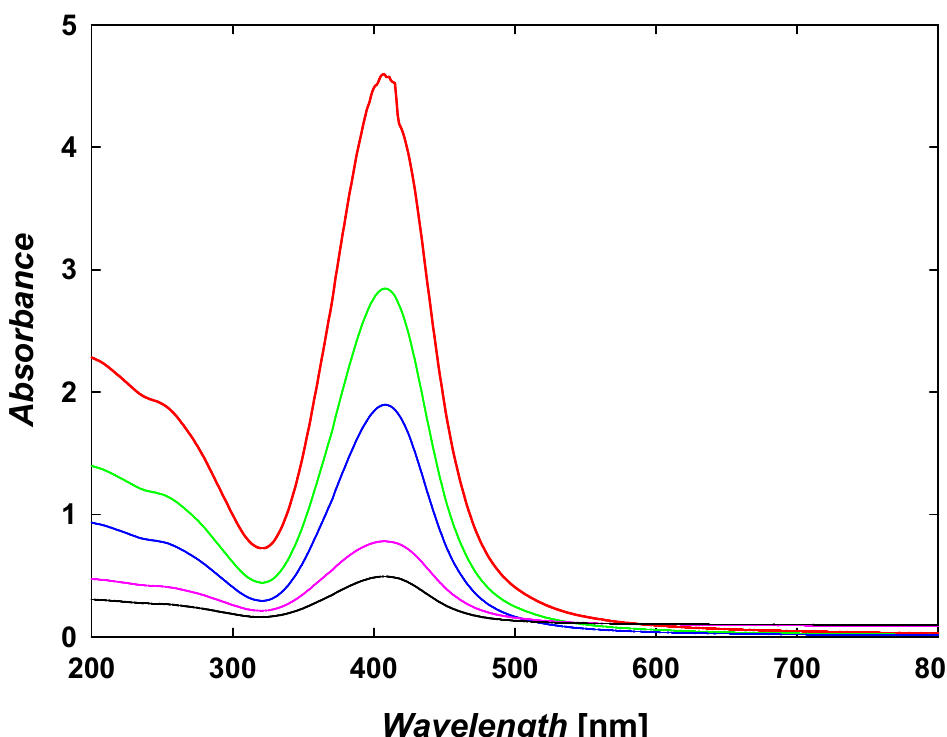
Figure 1. Extinction spectra of TA-AgNP suspensions of the controlled mass concentration of nanoparticles. Extinction spectra of TA-AgNP suspensions of the controlled mass concentration of nanoparticles ( ___ ) 5 mg L -1 , ( ___ ) 10 mg L -1 , ( ___ ) 20 mg L -1 , ( ___ ) 25 mg L -1 , ( ___ ) 50 mg L -1 .